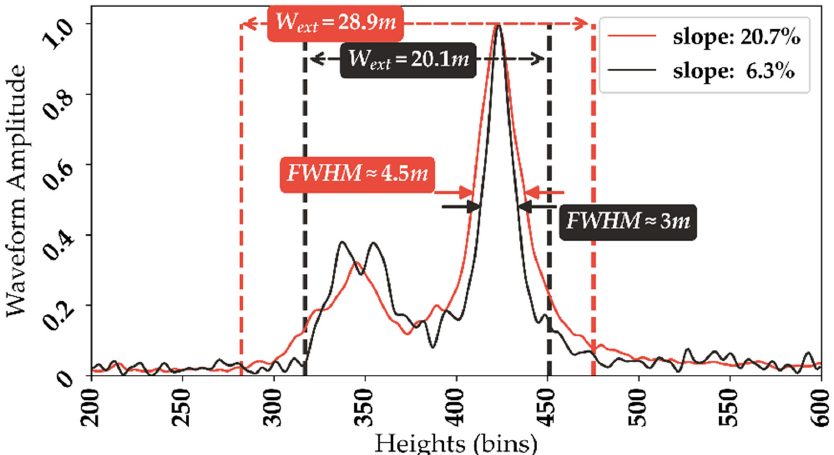
Figure 4. GEDI waveforms acquired over two Eucalyptus stands with the same H dom (~16.75 m) but different terrain slopes. The dashed lines represent the toploc and botloc positions. The full width at half maximum (FWHM) is indicated for the ground peak. Both waveform amplitudes were normalized to be between 0 and 1 for comparison purposes.